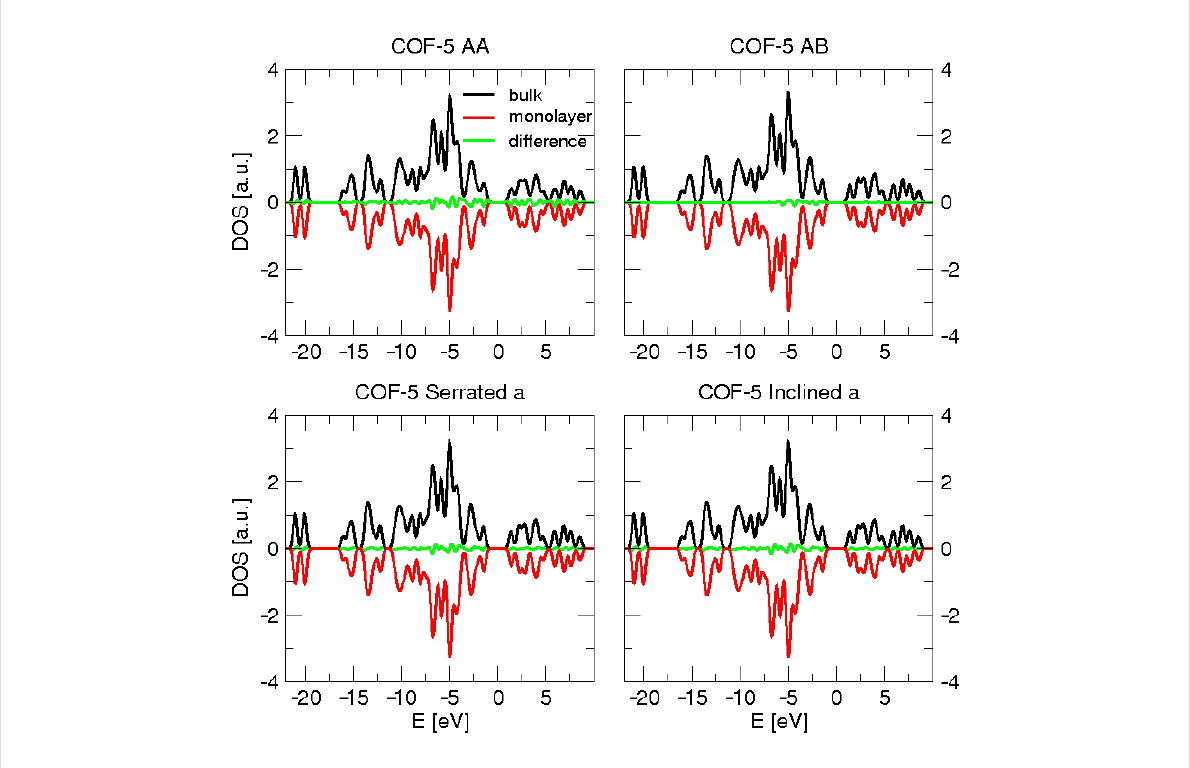
Figure 6: Total densities of states (DOS) (black) of AA (top left), AB (top right), serrated (bottom left), and inclined (bottom right), comparing stacked COF-5 with a monolayer (red) of COF-5. The differences between the TDOS of bulk and monolayer structures are indicated in green. The Fermi level E F is shifted to